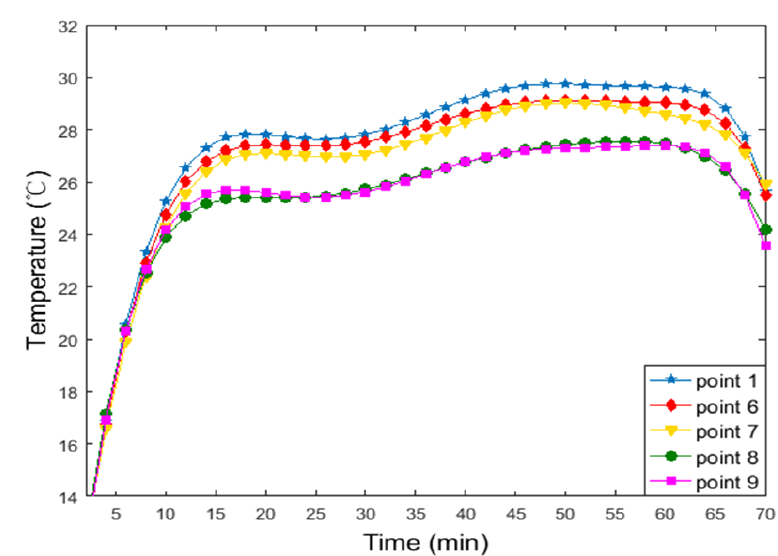
Figure 14. Temperature of each point in Experiment 3.